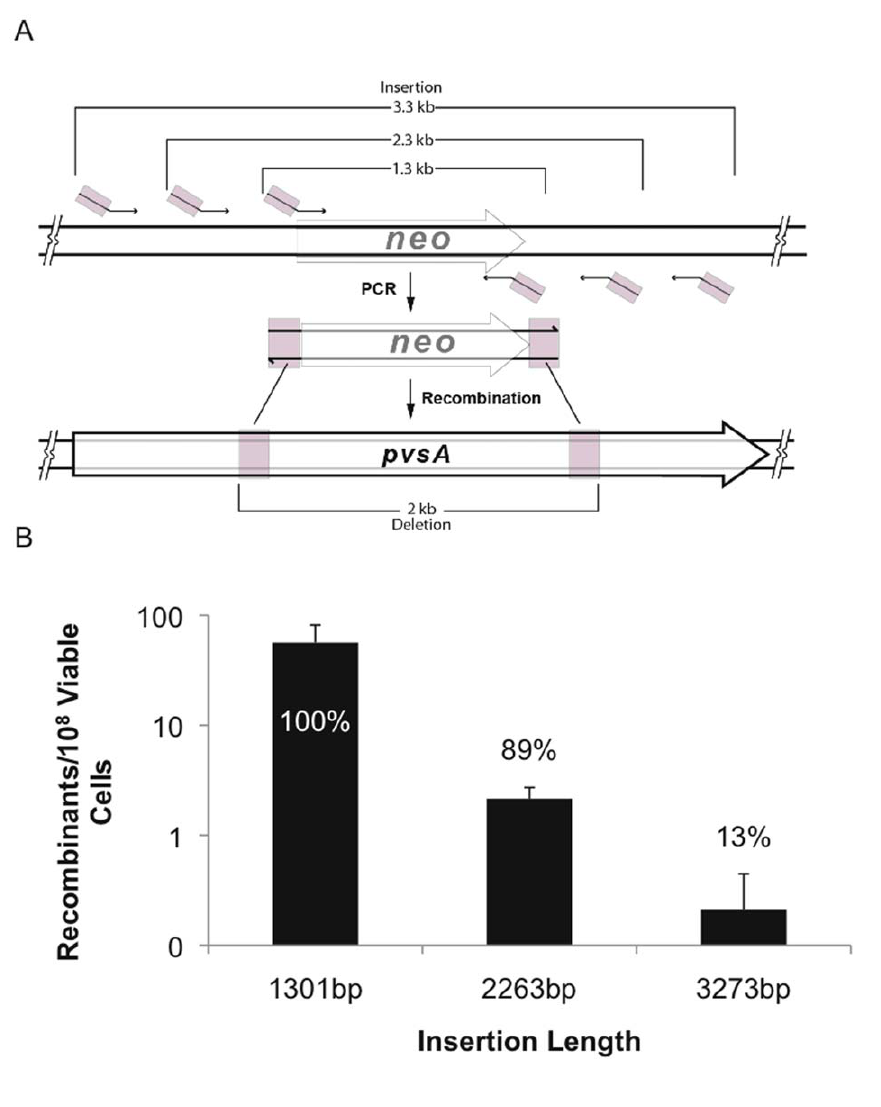
Figure 5. Insertion length influences recombination efficiency. (A) The length of the region between the homologous flanking sequences was varied to evaluate whether its length affects recombination frequency. Substrates were designed to generate a 2 kb chromosomal deletion upon insertion of the length indicated. Homologous sequences are shown in pink. (B) Recombineering efficiency with substrates that insert different amounts of sequence. PCR was used to analyze the pvsA alleles of 8–18 kanamycin resistant clones for each deletion length to determine whether the neo gene had integrated and produced the deletion in the correct location. The percentage of kanamycin resistant clones with the correct deletion is indicated above each bar. The results are the average of three independent replicates, error bars indicate standard